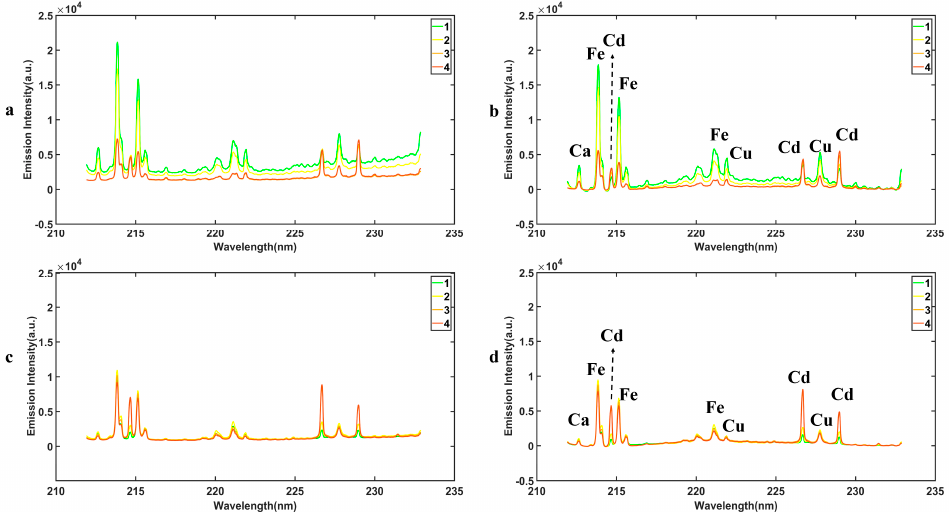
Figure 1. LIBS spectra. The average raw LIBS spectra of Cd concentration before pyrolysis ( a ) and after pyrolysis ( b ); LIBS spectra of samples containing Cd before pyrolysis ( c ) and after pyrolysis ( d ) preprocessed by adaptive iteratively reweighted penalized least squares (airPLS).